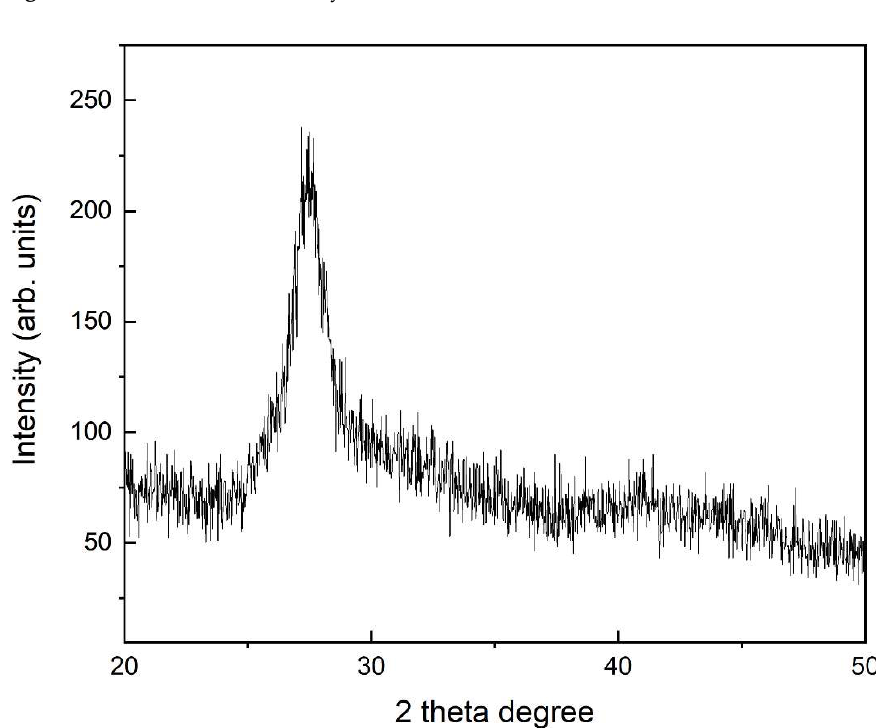
Figure 8. XRD of HEC.